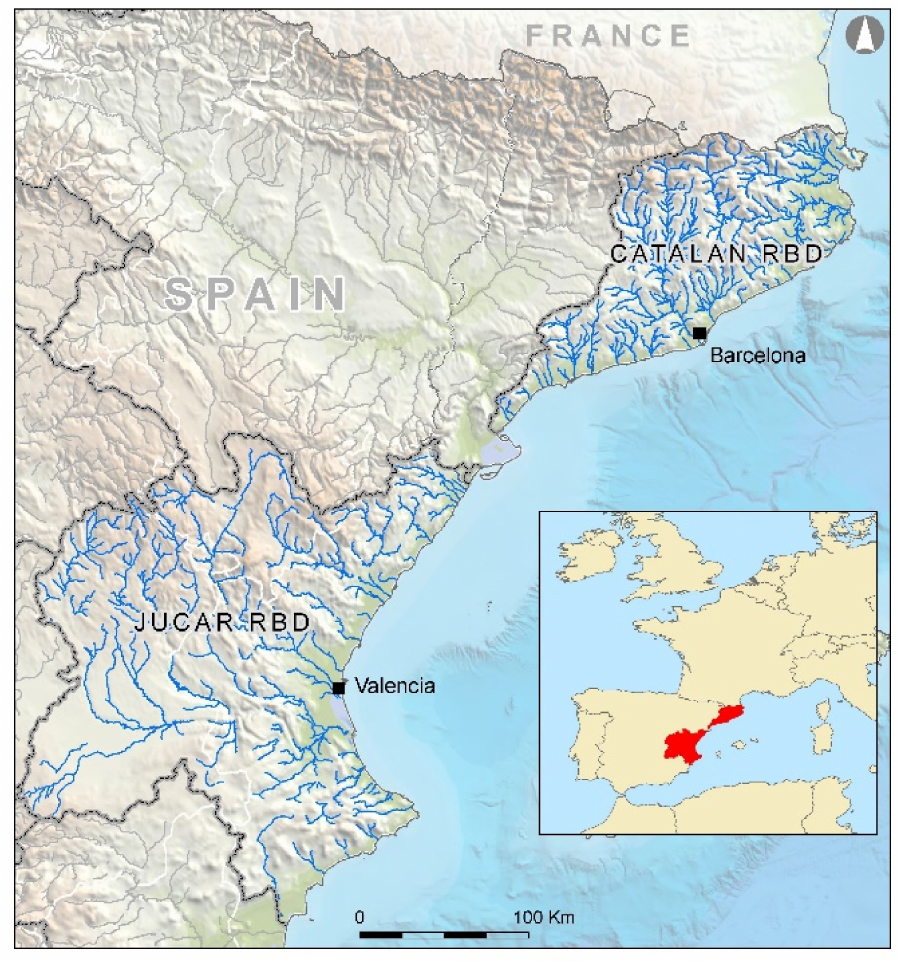
Figure 1. Location of the Catalan and J ú car river basin districts